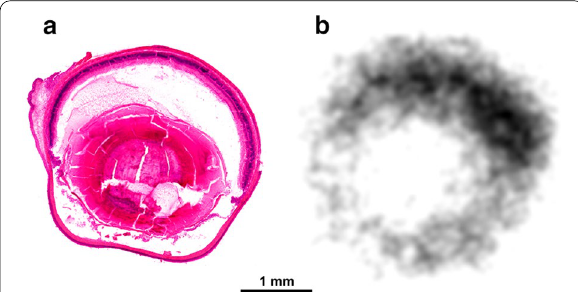
Fig. 4 HE staining ( a ) and corresponding autoradiography image ( b )